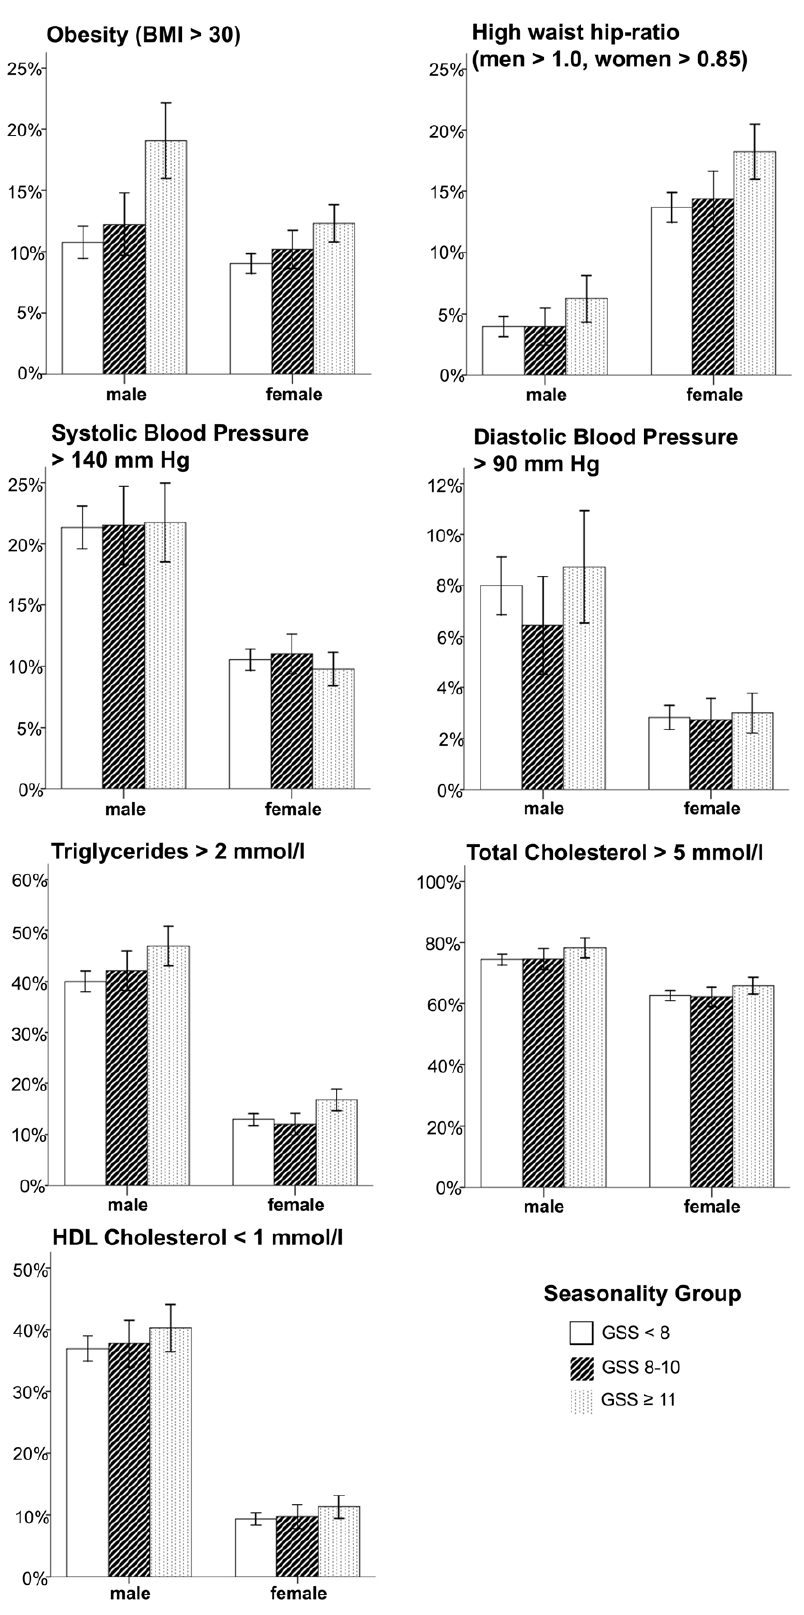
Figure 1. Prevalence of objective health risk factors associated with cardiovascular disease in different seasonality groups. Each chart has prevalence of health risks on the vertical axis and seasonality group on the horizontal axis, and results for men and women are shown separately. GSS=Global Seasonality Score. Vertical lines depict the 95% Confidence intervals.